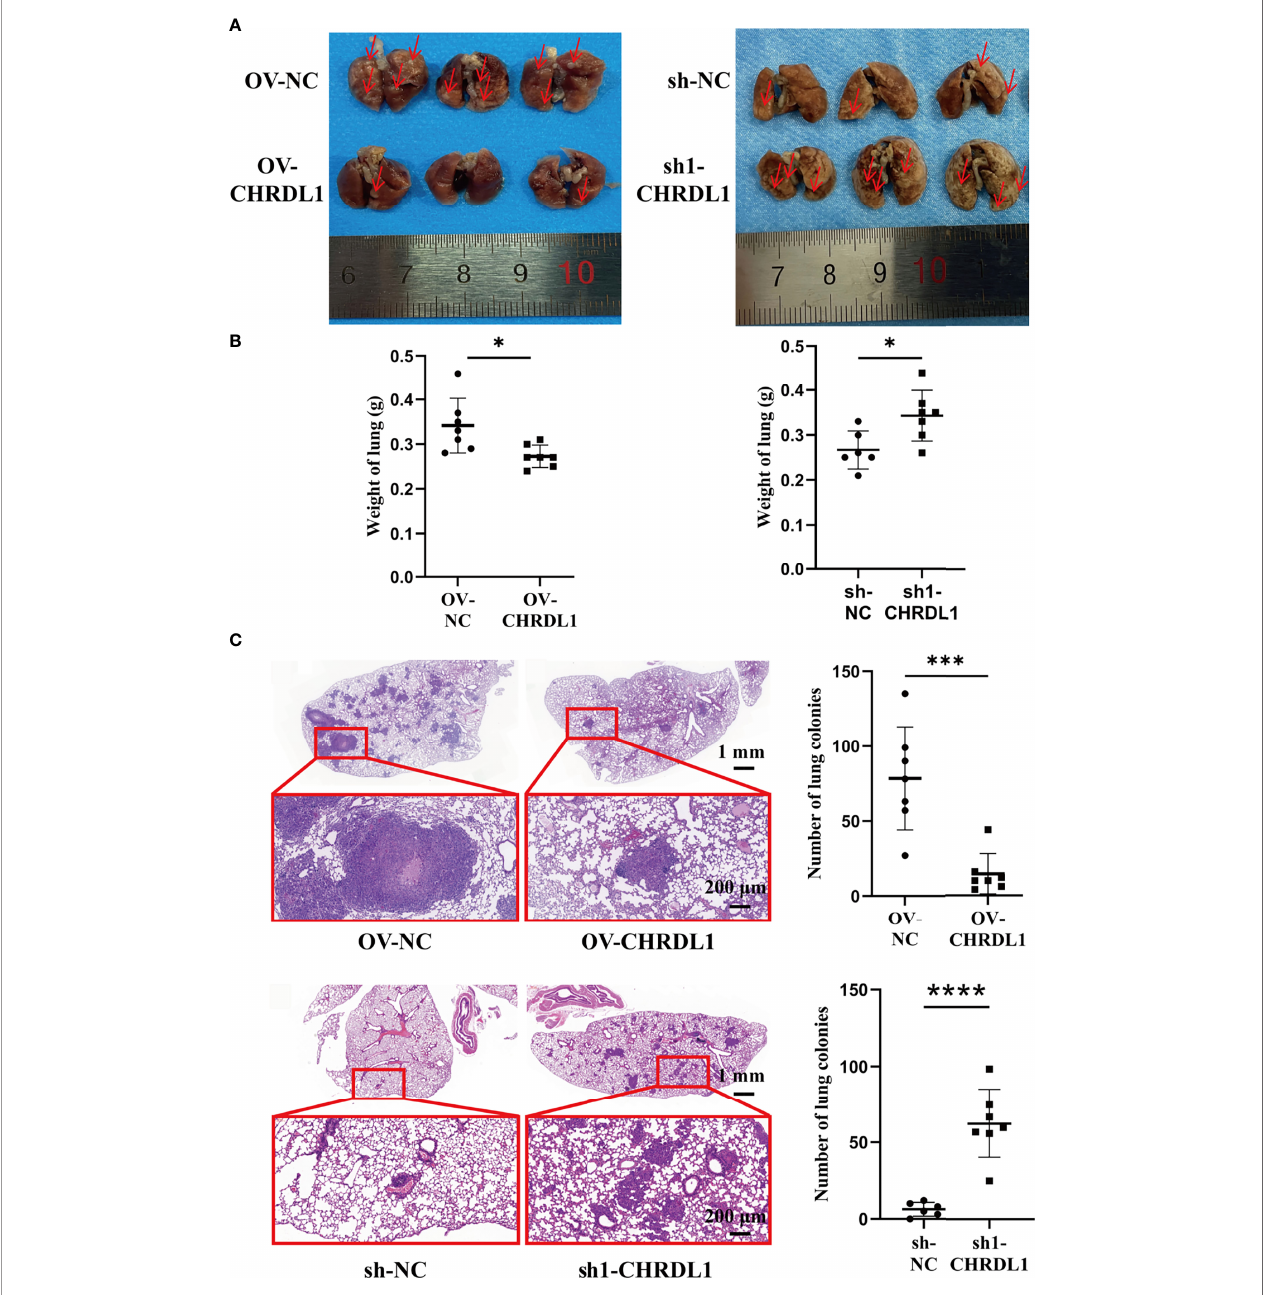
FIGURE 6 | Effects of CHRDL1 on CAL27 cells in vivo . (A) Representative images of the lungs of BALB/c nude mice at 9 weeks after inoculation with OV-NC/OV- CHRDL1 (left) or sh-NC/sh1-CHRDL1 (right) CAL27 cells by tail vein injection. The red arrows show nodules on the lung surfaces. (B) Weights of the lungs of BALB/ c-nude mice inoculated with OV-NC/OV-CHRDL1 (left) or sh-NC/sh1-CHRDL1 (right) CAL27 cells by tail vein injection. (C) Photomicrographs of hematoxylin-and- eosin-stained lungs of mice injected with OV-NC/OV-CHRDL1 (up) or sh-NC/sh1-CHRDL1 (down) CAL27 cells. Error bars represent the standard deviation. * p < 0.05, *** p < 0.001, **** p <